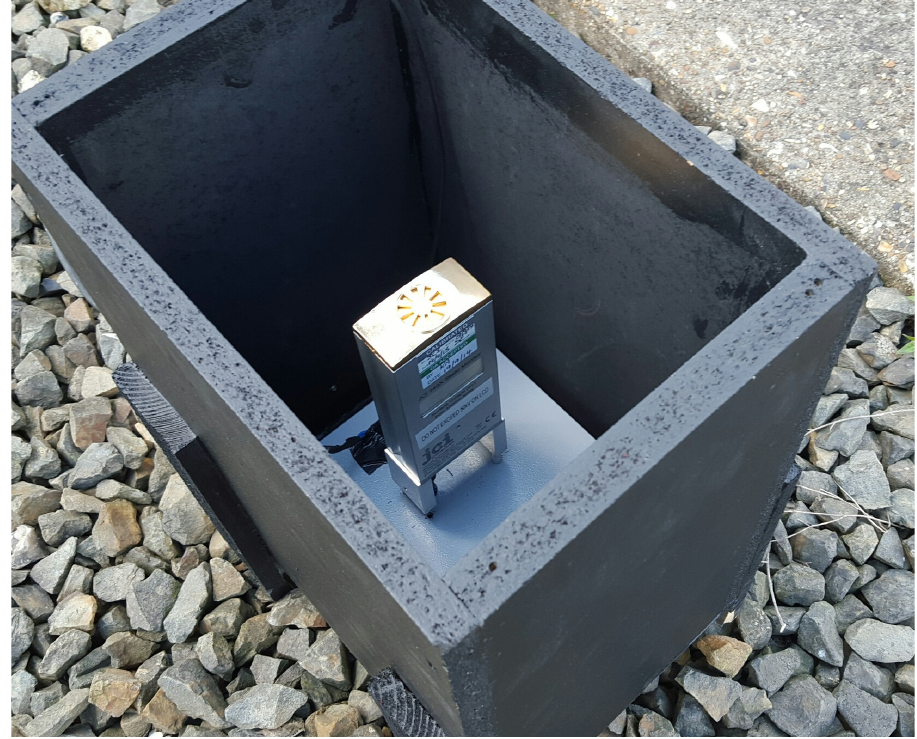
Figure 4. Photograph of the FM inside fabricated